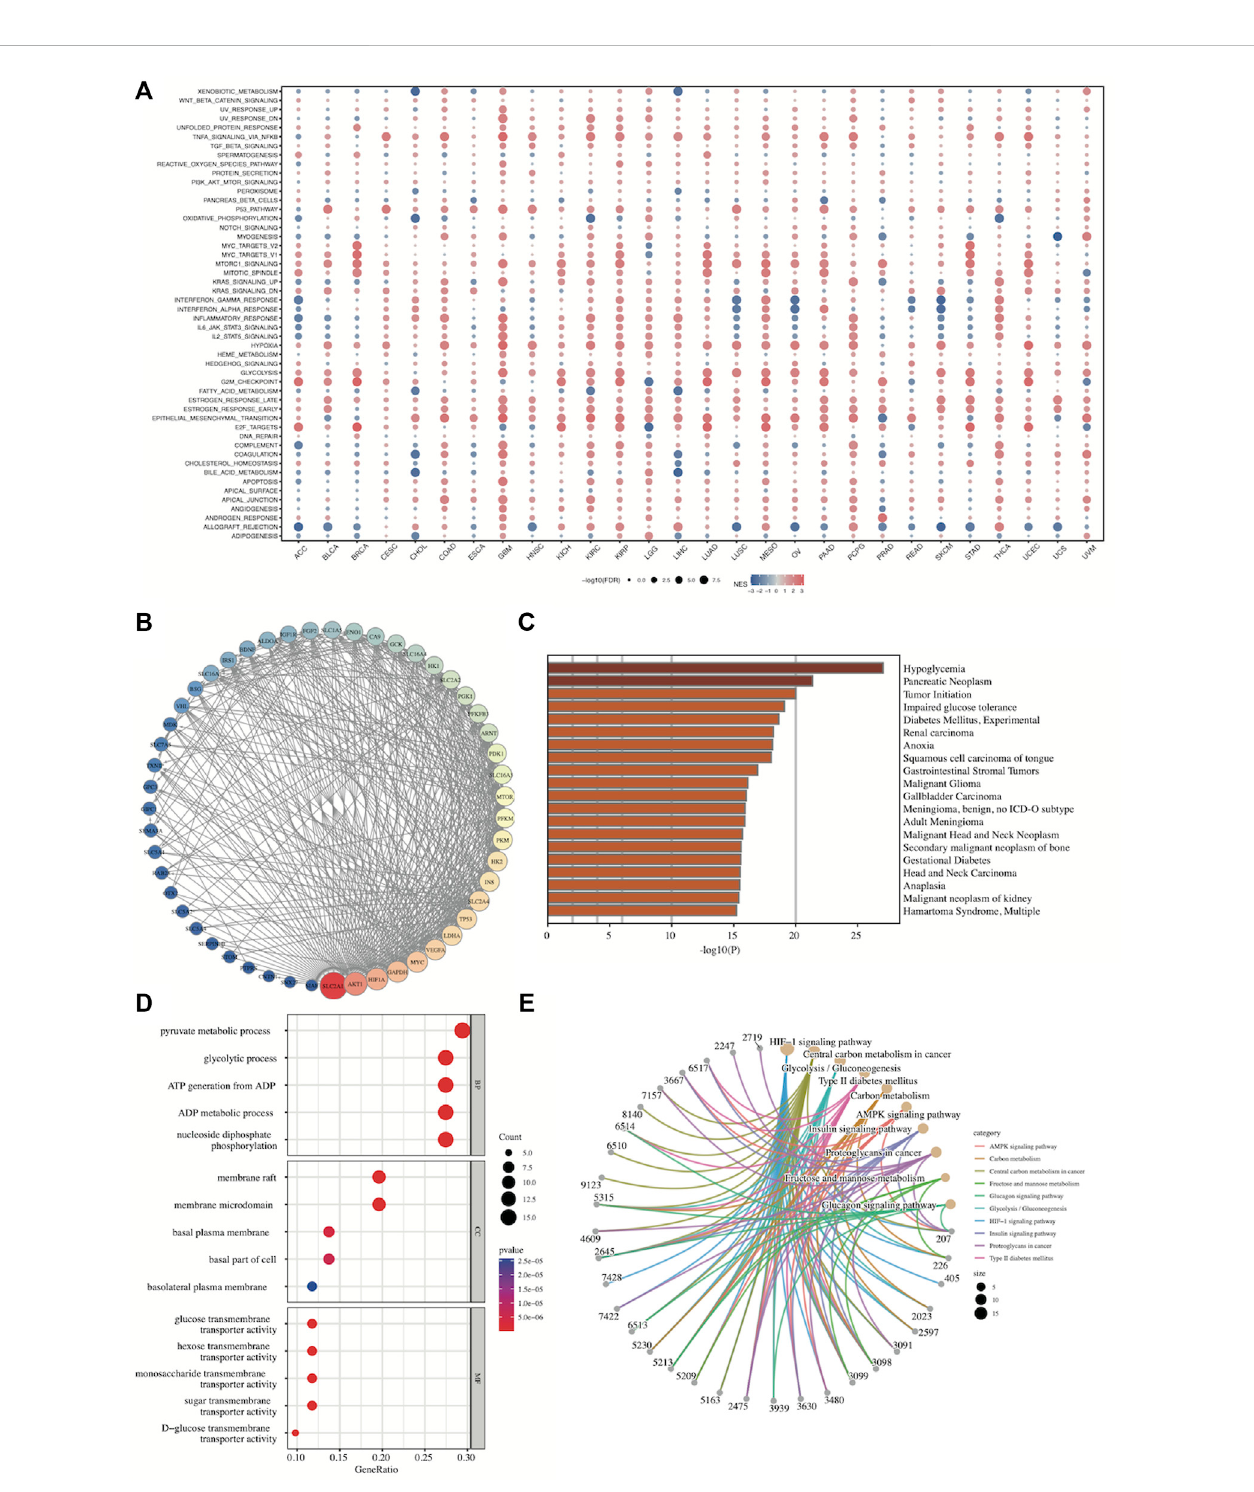
FIGURE 13 Gene Set Enrichment Analysis and protein-protein interaction network of SLC2A1 (A) The correlation analysis between SLC2A1 and the enrichment scores of 50 HALLMARK pathways across TCGA cancers (B) Construction of PPI network involved in 51 SLC2A1-interacting proteins based on STRING and adjusted by Cytoscape (C) The disease speci fi c enrichment analysis for SLC2A1-related genes by Metascape (D) The GO enrichment analysis for SLC2A1- relatedgenescontainedinPPInetwork (E) TheKEGGenrichmentanalysisforSLC2A1-relatedgenescontainedinPPInetwork.FDR,falsediscoveryratio; NES, normalized enrichment